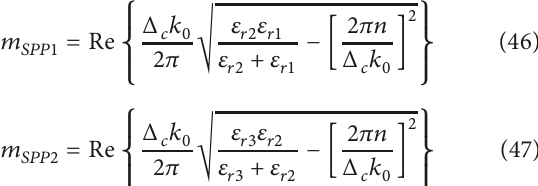
Figure 11: Component 𝑧 of the electric field 20 log | Re {𝐸𝑧}| , in dB, in the planes: (a) 𝑥𝑦 and (b) 𝑥𝑧 ; Component 𝑦 of the magnetic field 20 log | Re {𝐻𝑦}| , in dB, in the planes: (c) 𝑥𝑦 and (d) 𝑥𝑧 . In these results we set the following: 𝛿 𝜃 󸀠 = 0 ∘ , and 𝜙 󸀠 = 0 ∘